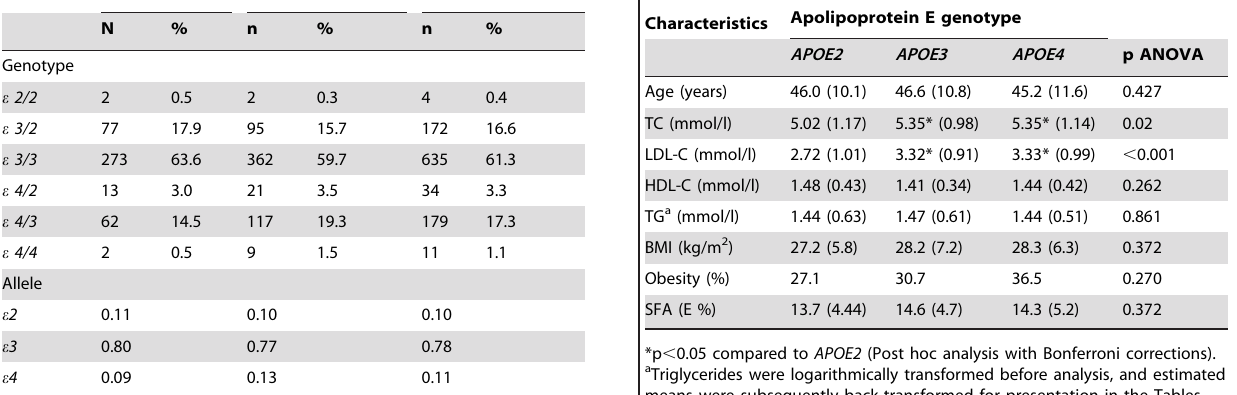
Table 3. Characteristics of the population (means and standard deviations (SD) or percentage) according to apolipoprotein E genotype (women).